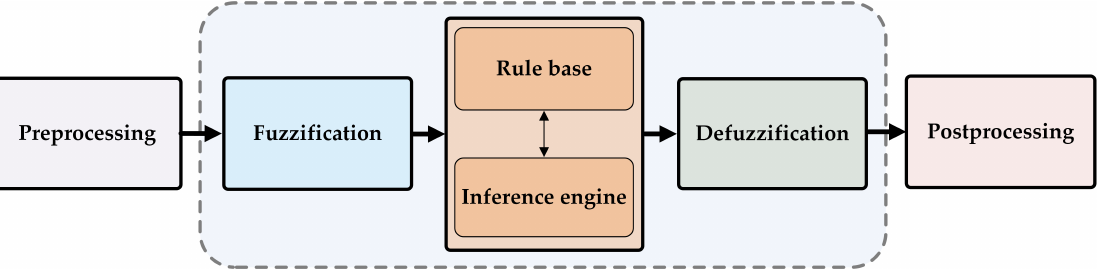
Figure 2. Fuzzy control flow